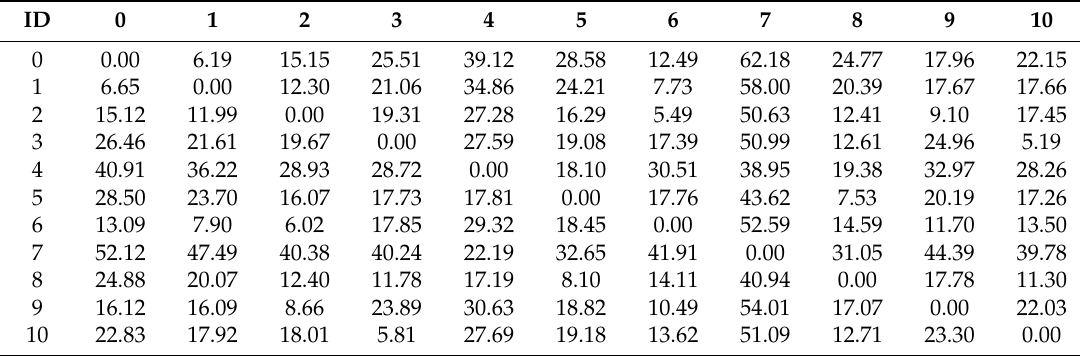
Table 4. Travel time budgets between the warehouse and flooded areas with on-time probability α = 0.9 (min).